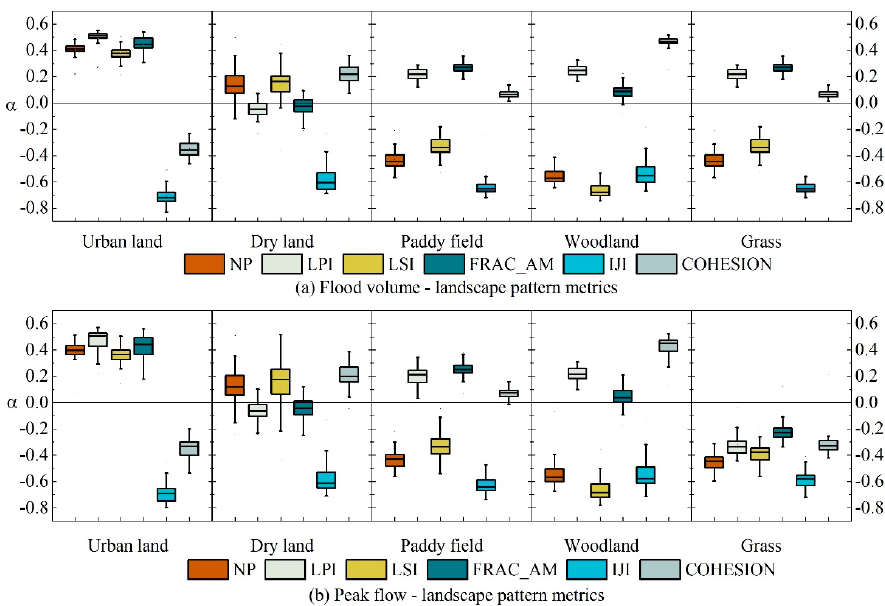
Figure 6. Box diagrams of correlation analysis results.